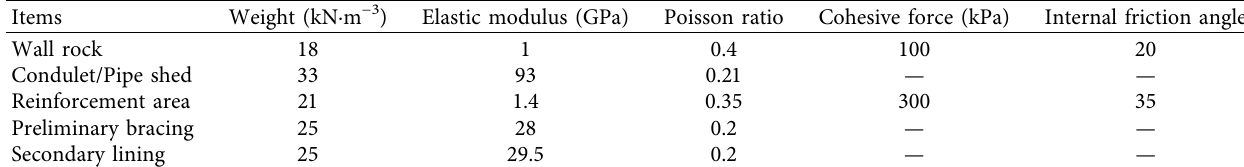
Table 2: Parameter of numerical calculation.